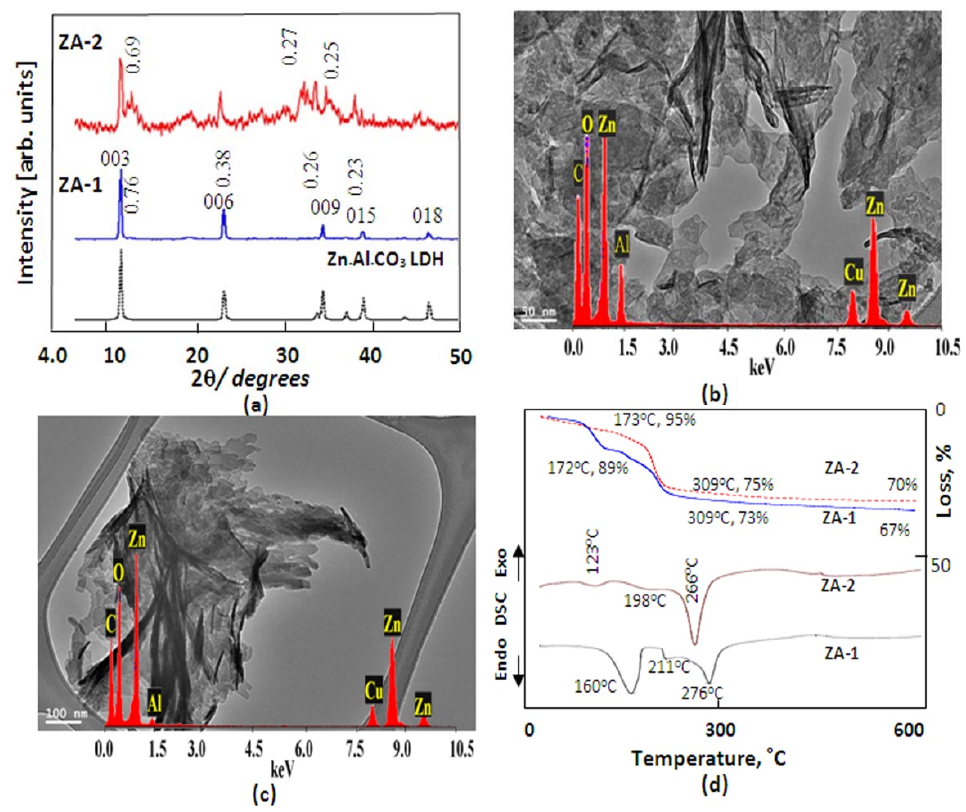
Figure 1. Samples ZA-1 and ZA-2: ( a ) X-ray diffraction ( b,c ); TEM images and EDX spectra; and ( d ) thermal analyses.